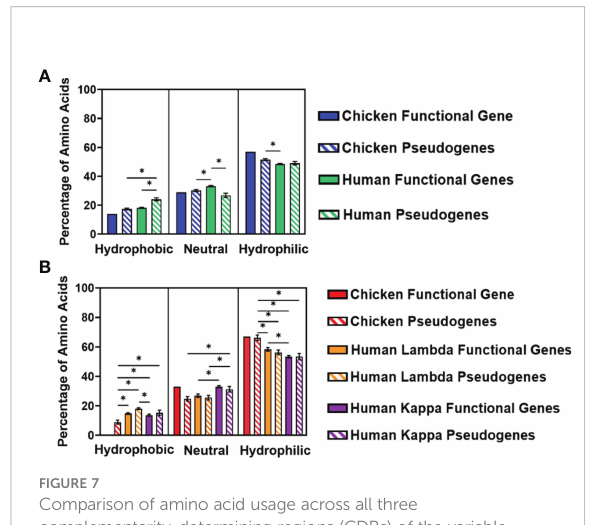
FIGURE 7 Comparison of amino acid usage across all three complementarity-determining regions (CDRs) of the variable germline genes of both chickens and humans, categorising amino acids by their hydrophobicity, displaying amino acid usage in (A) the immunoglobulin heavy chain and (B) immunoglobulin light chain. Hydrophobic amino acids, phenylalanine, (Phe); leucine, (Leu); isoleucine, (Ile); methionine, (Met); valine, (Val); cysteine, (Cys); and tryptophan, (Trp); Neutral amino acids, serine; proline, (Pro); threonine, (Thr); alanine, (Ala); tyrosine, (Tyr); and histidine, (His); Hydrophilic amino acids, glycine, (Gly); glutamine, (Gln); asparagine, (Asn); lysine, (Lys); aspartic acid, (Asp); glutamic acid, (Glu); and arginine, (Arg). Datasets were statistically analysed using a one-way ANOVA. p-Values: *p ≤